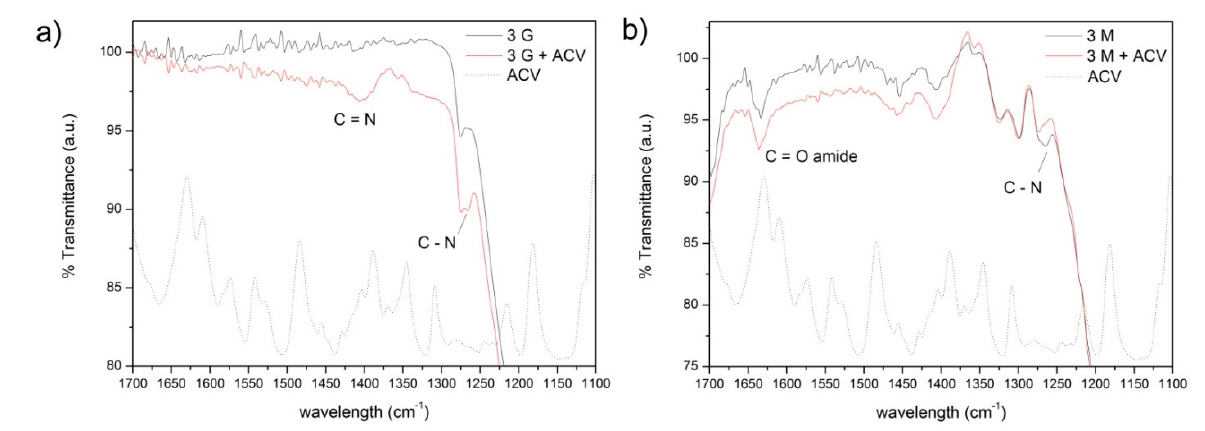
Figure 11. FTIR spectra of the mesoporous materials loaded with ACV and functionalized with ( a ) GLYMO and ( b ) MEMO. Dotted lines show the FTIR spectra of the drug molecule ACV.